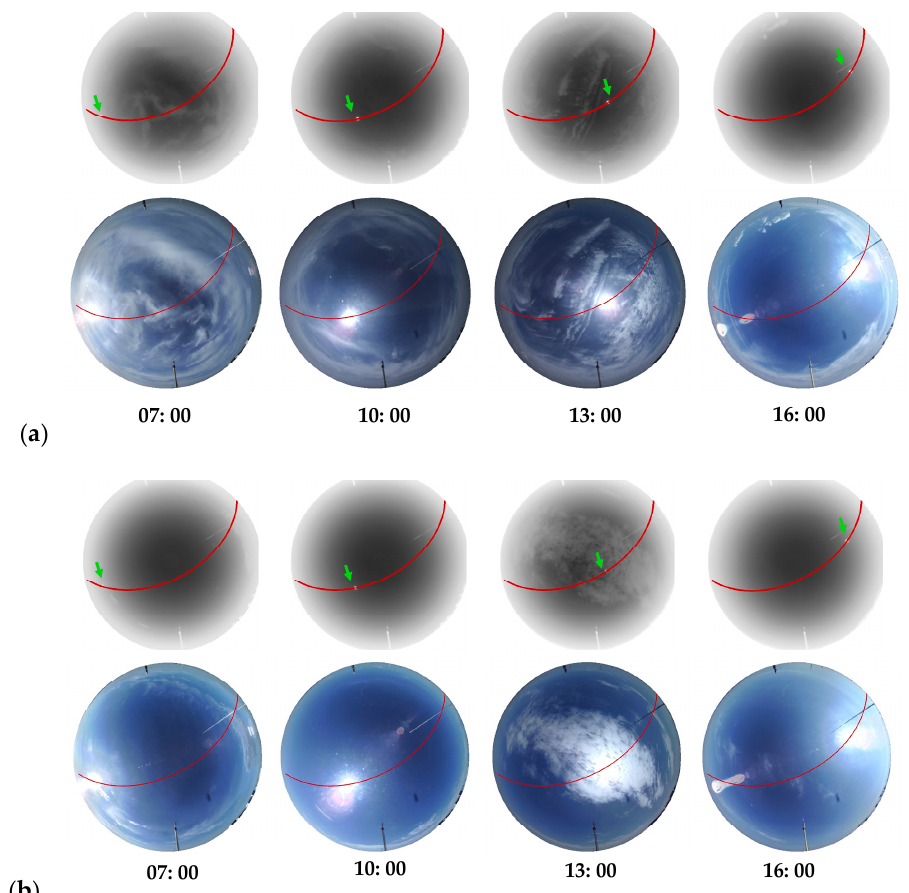
Figure 6. Synthetic sun trajectory (red line) on infrared and visible all-sky images captured on ( a ) 2 August 2020 and ( b ) 13 August 2020 (all are local time). The green arrows point at the sun’s positions that are unobvious in the infrared all-sky images.